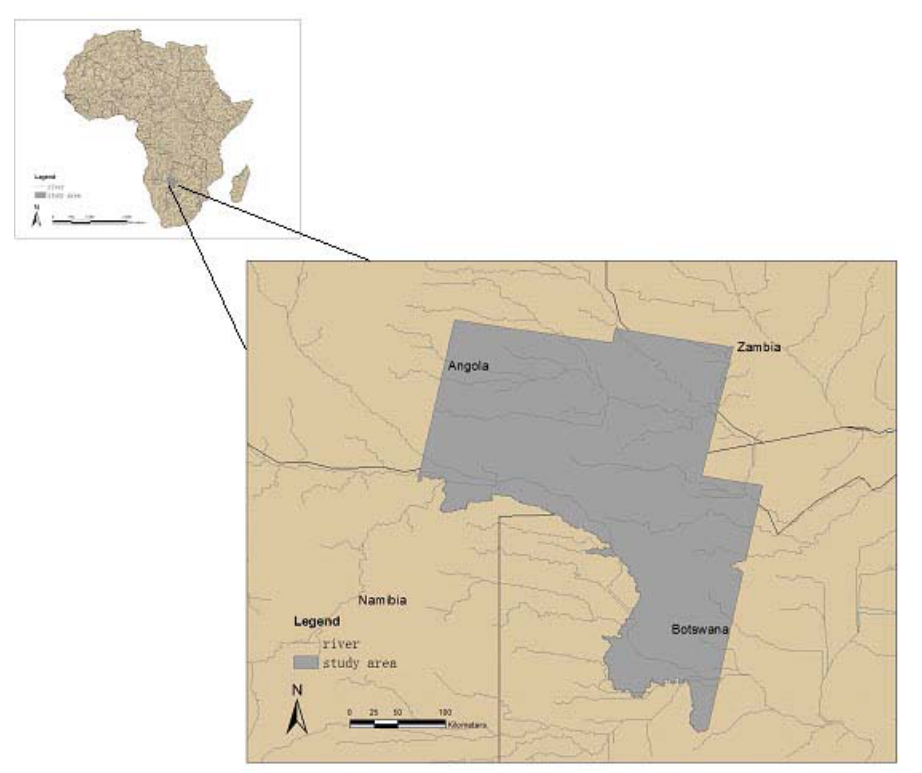
Figure 1. Study area situated within the proposed Kavango-Zambezi Transboundary Conservation Area